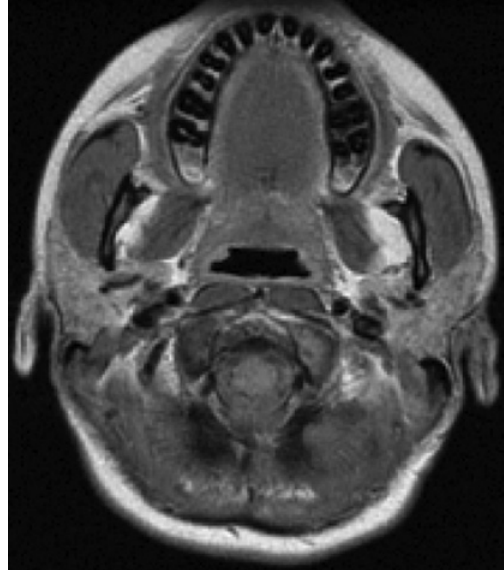
Figure 6: Extracted Watermarked Image.